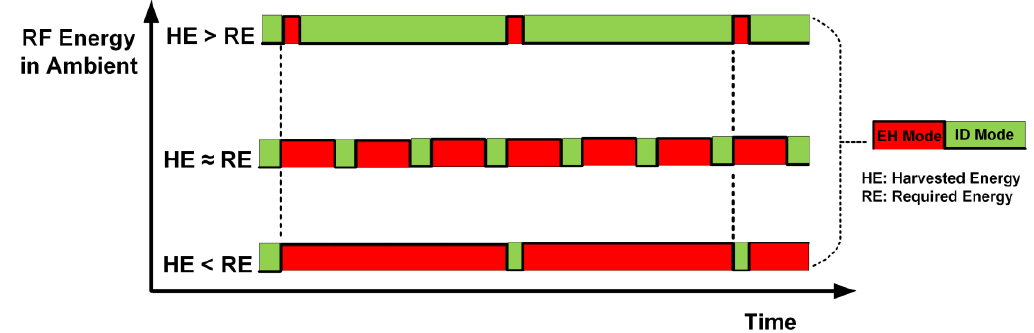
Figure 3. SWIPT receiver duty ratio depending on the RF energy in the ambient environment.